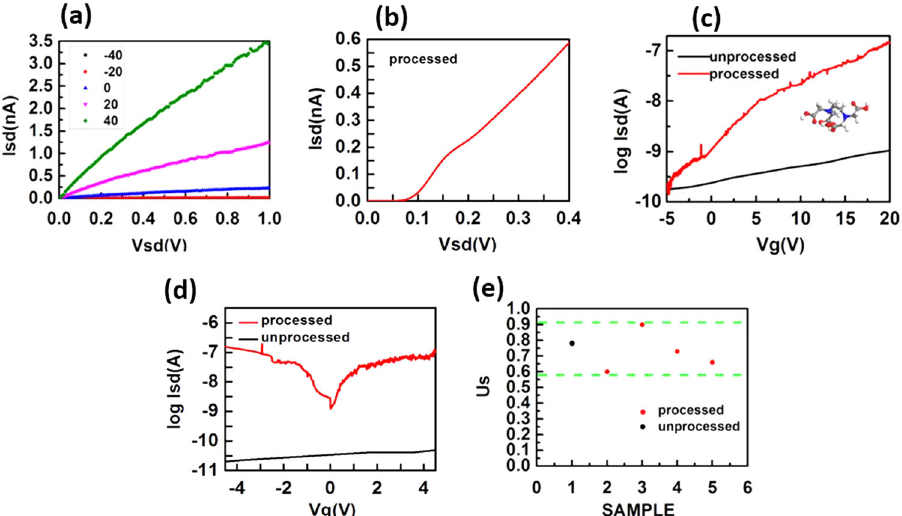
Fig. 2 Repaired SLM device with three orders of magnitude higher mobility. a I sd -V sd characteristics of CVD-synthesized monolayer MoSe 2 at gate voltages of − 20, 0, 20, 40 V. b I sd -V sd characteristics of CVD-synthesized monolayer MoSe 2 at zero gate voltage. c I sd -V g curves of CVD- synthesized monolayer MoSe 2 before ( black ) and after ( red ) the EDTA processing. d I sd -V g curves of another sample before ( black ) and after ( red ) processed by EDTA, shows the improved hole mobility of SLM sheet. e The Schottky barrier values of fi ve different samples, black for the unprocessed sample and red for the processed sample,